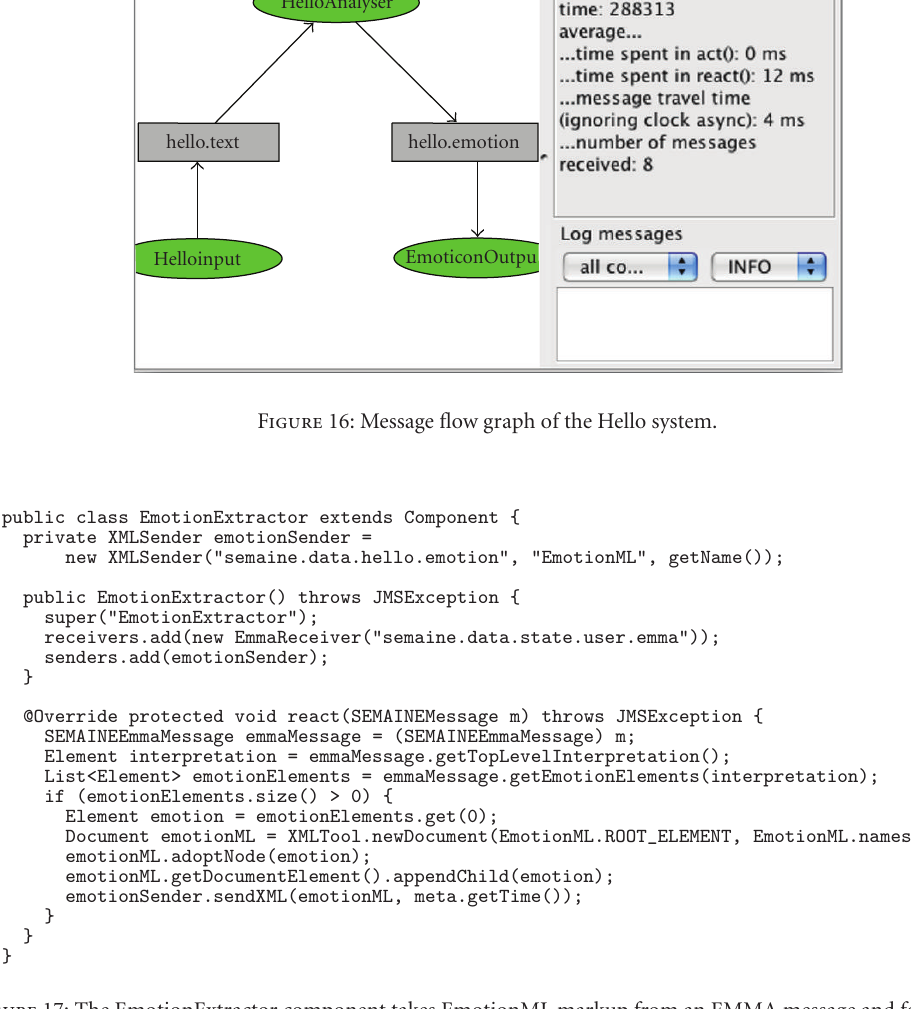
Figure 17: The EmotionExtractor component takes EmotionML markup from an EMMA message and forwards